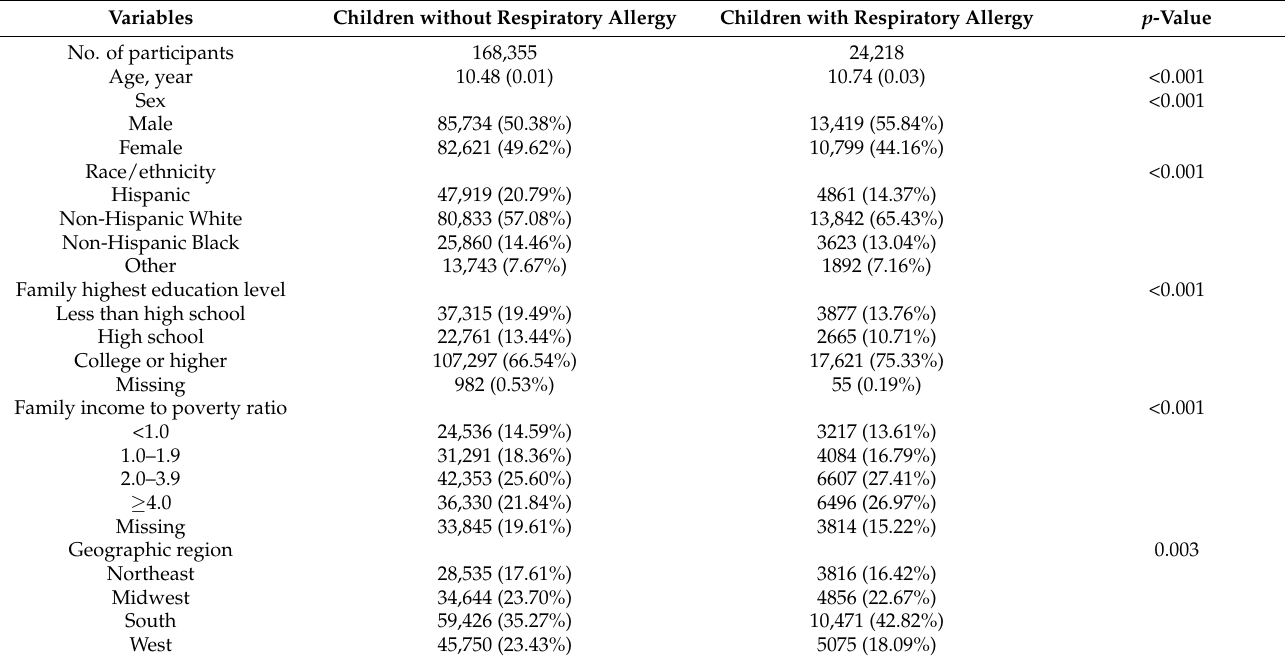
Table 2. Characteristics of the participants ( n = 192,573), according to respiratory allergy.